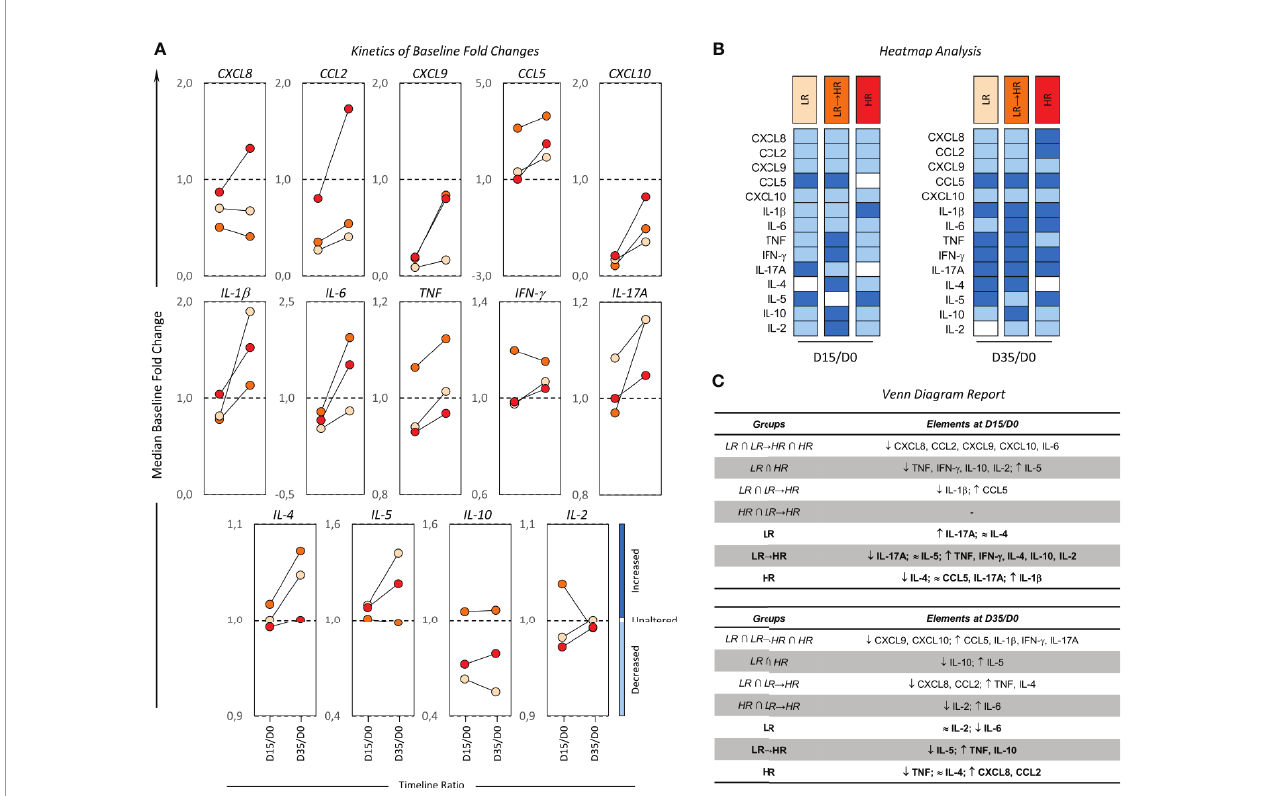
FIGURE 3 | Kinetics of baseline fold changes on bone marrow soluble mediators from B-ALL patients according to their risk group strati fi cation. (A) The median ratio of biomarker levels detected on D15 and D35 in relation to the baseline was determined for B-ALL patients categorized according to their risk group strati fi cation on D15 of induction therapy are as follows: LR ( ), LR ! HR ( ) and HR ( ) subgroups. Changes in biomarker levels on D15 and D35 were analyzed since they exhibited increased (baseline fold >1), unaltered (baseline folds=1) or decreased (baseline fold <1) levels in relation to D0. (B) The heat map compiles the changes in bone marrow biomarkers to identify the behavior patterns of soluble mediators in clinical subgroups. (C) Venn diagrams identify common and selective biomarkers for each clinical